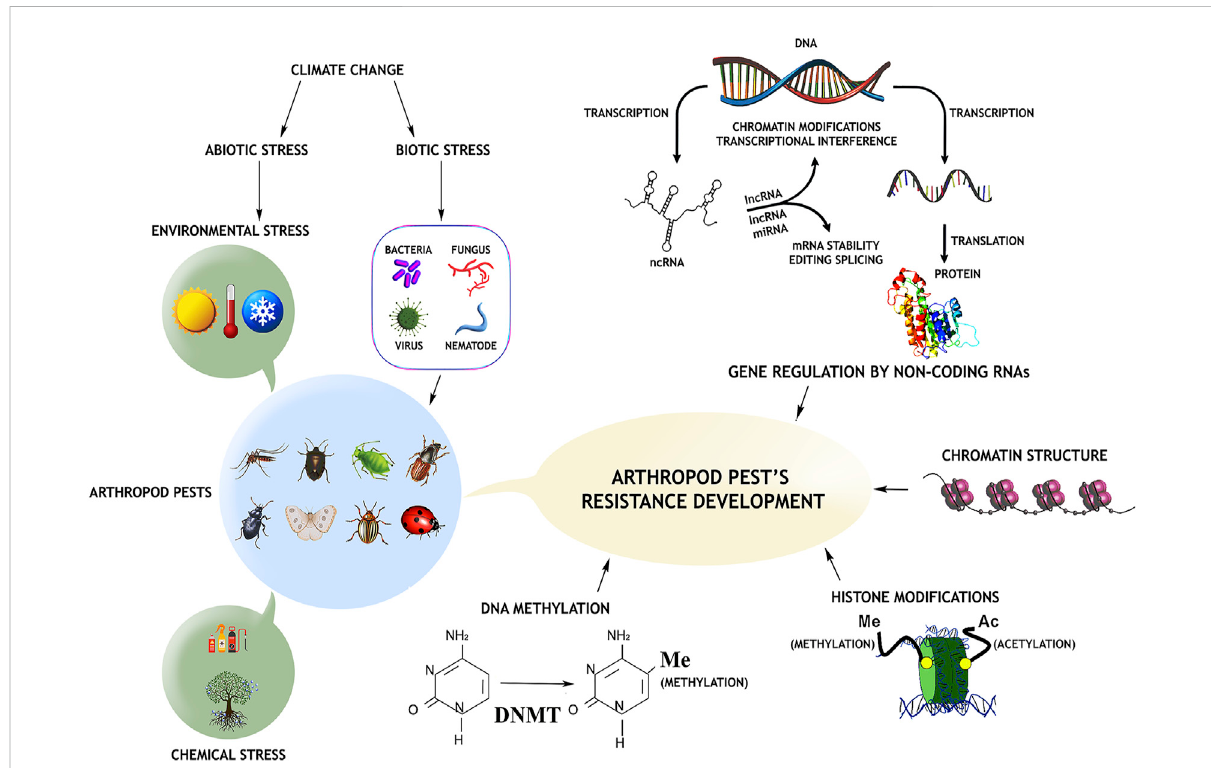
FIGURE 1 Arthropod pest resistance mechanisms emerge in response to environmental and insecticide challenges via epigenetic control. Epigenetic mechanisms include DNA methylation by DNA methyltransferase (DMNT) and histone modi fi cations (acetylation and methylation). Furthermore, non-coding RNAs are also involved in gene expression alteration by modifying DNA or RNA. (snRNA- small nuclear RNA, lncRNA- long non- coding